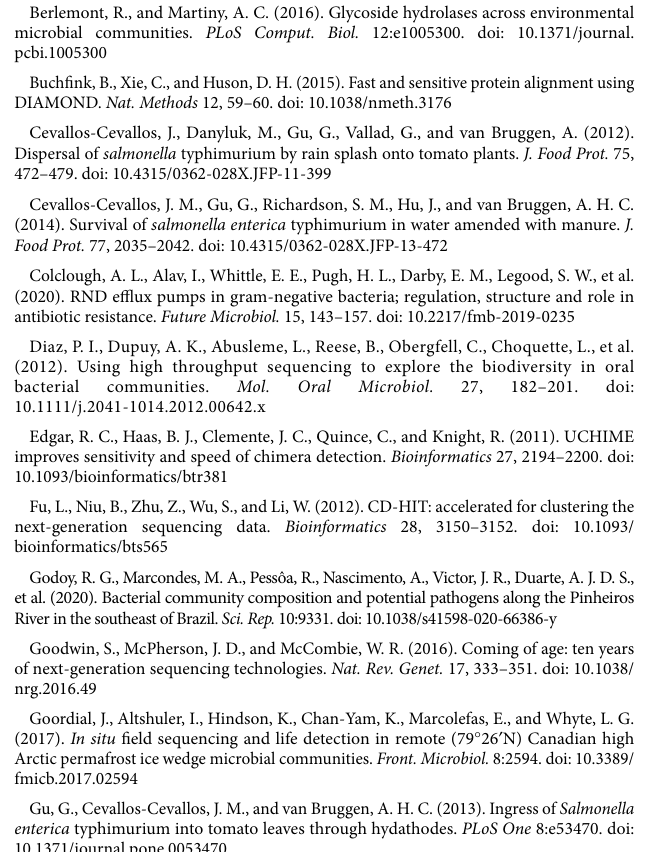
associated taro field water, and Cluster 3 (S-S3-N, T-S6-N, and R-S7-N) based on geographical location. SUPPLEMENTARY FIGURE 4 Bar plot comparing the (A) genus and (B) species classified with relative abundance of >1% in sample R-F1-E (Replicate 1 and Replicate 2) sequenced for full length amplicon using Oxford Nanopore MinION and analyzed on EPI2ME platform. Input valid reads that were not classified to genus and species levels are represented as “Unclassified”, while “ETC (<1%)” represents the bacterial population identified with relative abundance of <1%. SUPPLEMENTARY FIGURE 5 Comparison of samples R-F1-E and S-F3-N for relative abundance and statistical differences of annotated gene function profiles based on mapping of assembled metagenomic protein coding sequences to three databases: (A,B) non-supervised Orthologous groups (eggNOG), (C,D) Kyoto Encyclopedia of Genes and Genomes (KEGG), and (E,F) Carbohydrate-Active Enzymes Database (CAZy). Statistic al analyses performed using STAMP v 2.1.3 software, employing Fisher’s exact test with Newcombe-Wilson CI method and Benjamini-Hochberg FDR correction factors, and visualized using extended error bar plots. SUPPLEMENTARY FIGURE 6 Circos analysis displays the corresponding abundance relationship between identified dominant phyla (Proteobacteria and Actinobacteria) along with “other” representation of identified phyla and associated resistance mechanism. Circle chart is divided into two parts. The right side of the circle is phyla information, and the left side of the circle is antibiotic resistance mechanisms. Inner circle with different colors represents different antibiotic resistance mechanisms. The scale represents the relative abundance, and the unit is ppm. The left part represents the sum of relative abundance of different phyla for resistance mechanisms, while the outer right circle vice